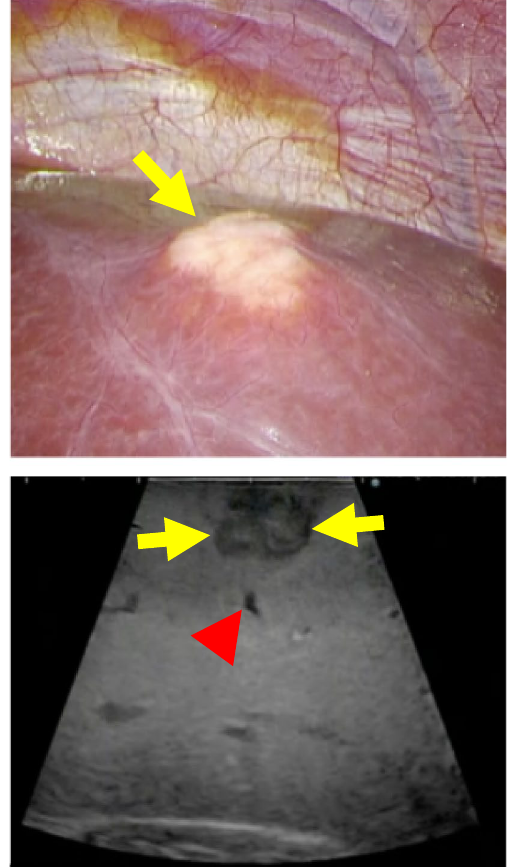
Fig. 3 In the pre-operative work-up of patients with liver tumors. Laparoscopy prior to hepatectomy revealed that the tumor was located in segment 7 on the liver surface (Yellow arrow). Intraoperative ultrasonography confirmed metastasis in segment 7. It was 18 mm in size and distant from the main glissons, right hepatic vein, middle hepatic vein, and vena cava (Yellow arrow). There was no peripheral glissons at the base of the tumor and a peripheral hepatic vein 2 mm in diameter was identified (Red